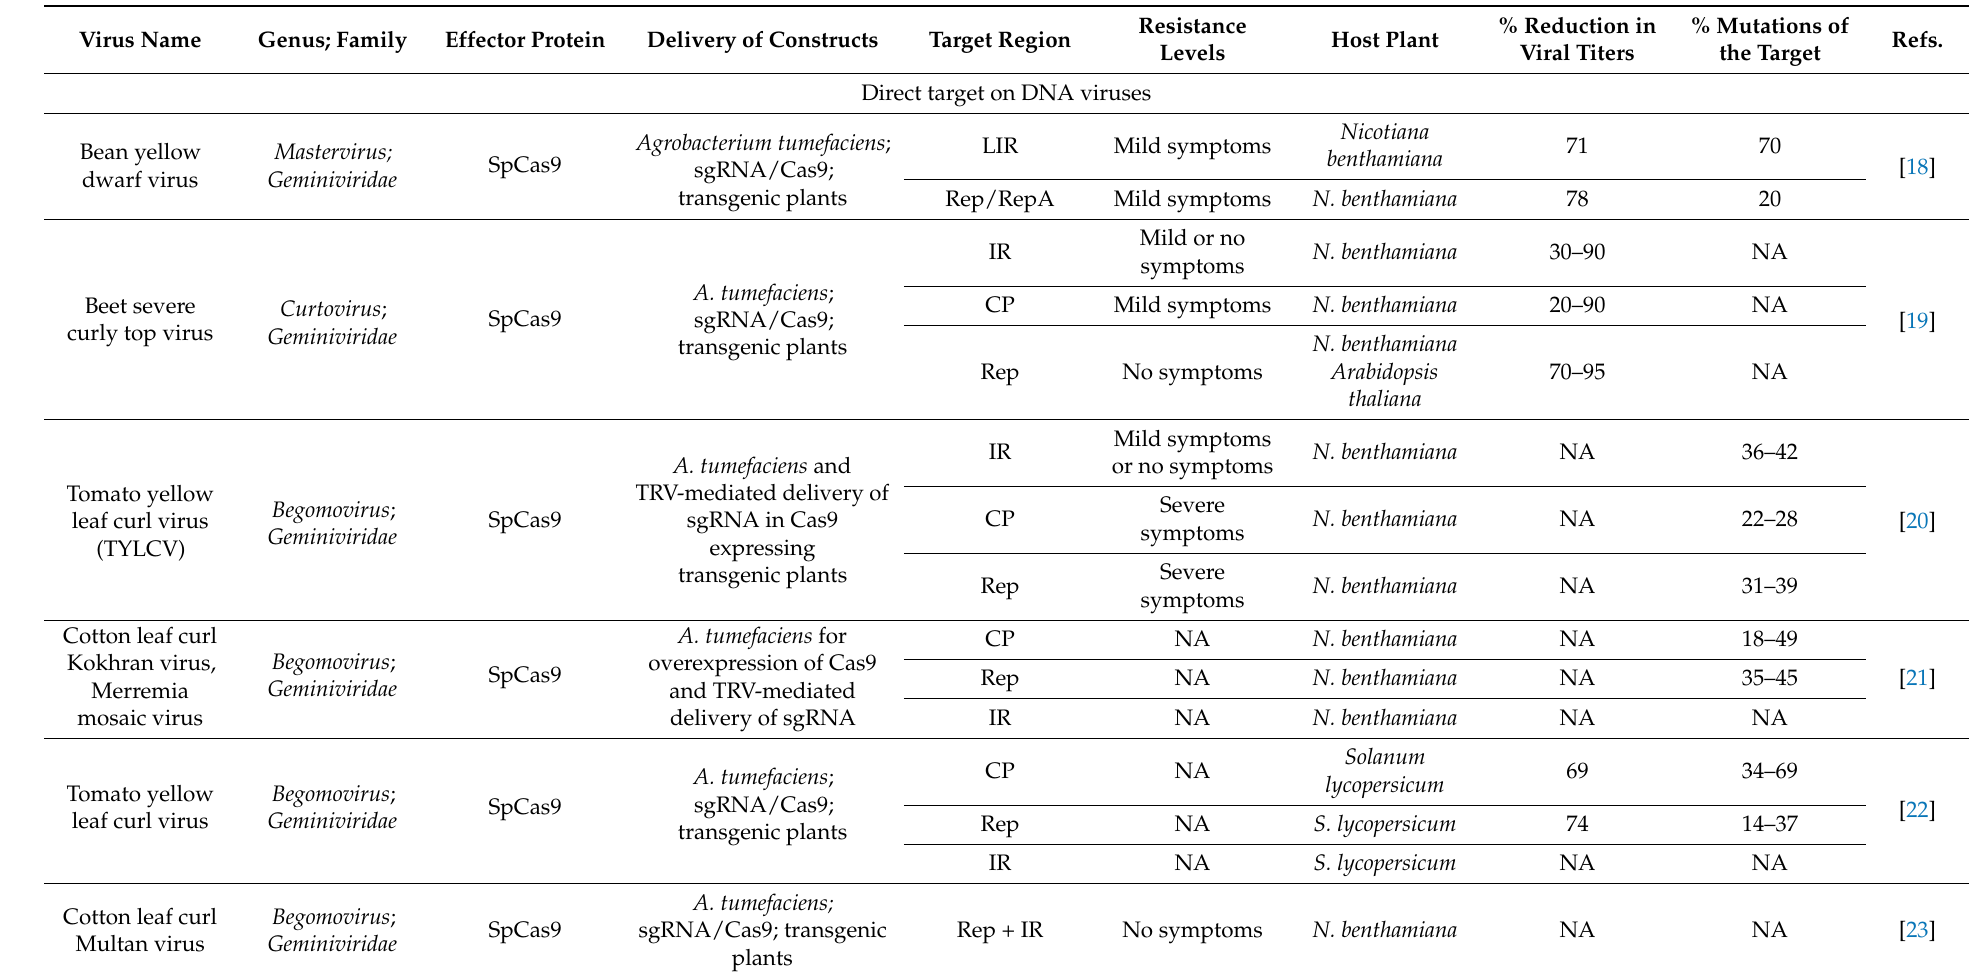
Table 1. Application of CRISPR/Cas in the development of virus resistance in